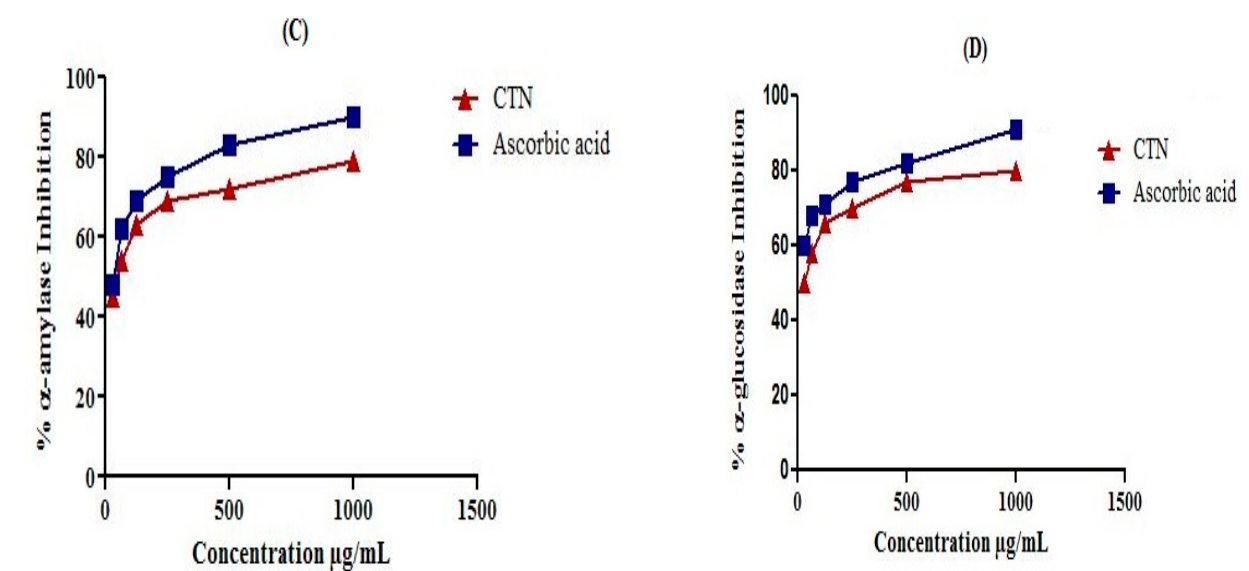
Figure 1. Percent in vitro free radicals (DPPH and ABTS) scavenging and antidiabetic ( α -amylase and α -glucosidase) activity of E. umbellata berries catechin. ( A ) % DPPH scavenging activity, ( B ) % ABTS scavenging activity, ( C ) percent α -amylase inhibition potential, ( D ) α -glucosidase inhibition potential of E. umbellata berries catechin at various concentra- tions.